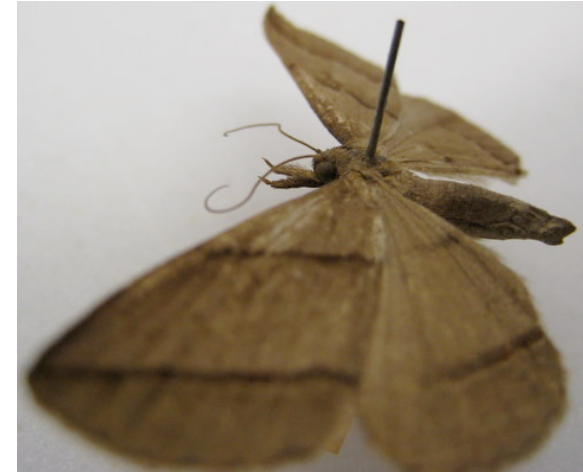
Image 6. Orthozona curvilineata female syntype showing palpi